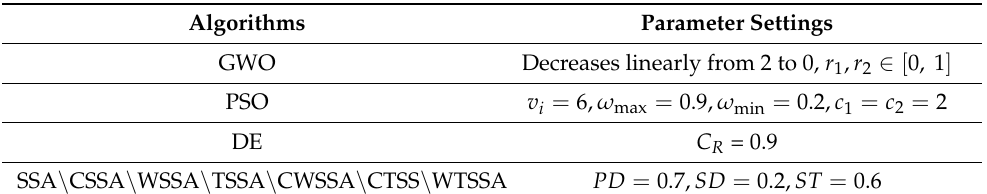
Table 2. Parameter settings for each algorithm.